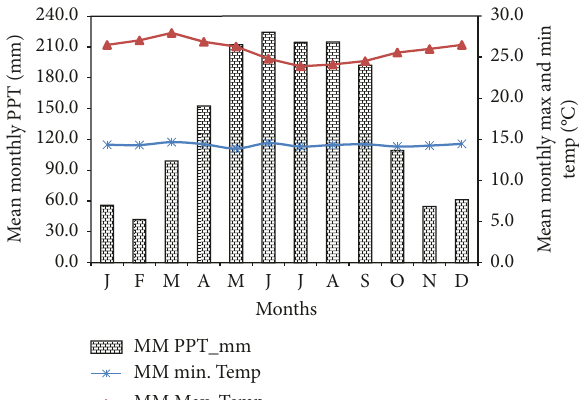
Figure 2: Mean monthly precipitation (mm) and mean monthly maximum and minimum temperature ( ° C) at Dirri meteorological station, Geshy subcatchment